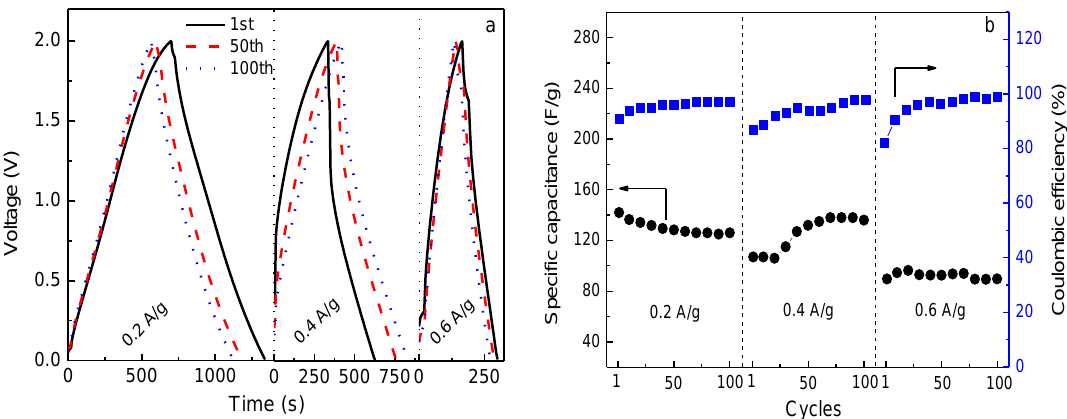
Figure 8. ( a ) Charge-discharge curves of 1st, 50th, and 100th cycles at different current densities under a charging voltage of 2 V for the EDLC fabricated with the P-40-10 electrolyte system, and ( b ) the corresponding cycling durability over 100 cycles for each current density.